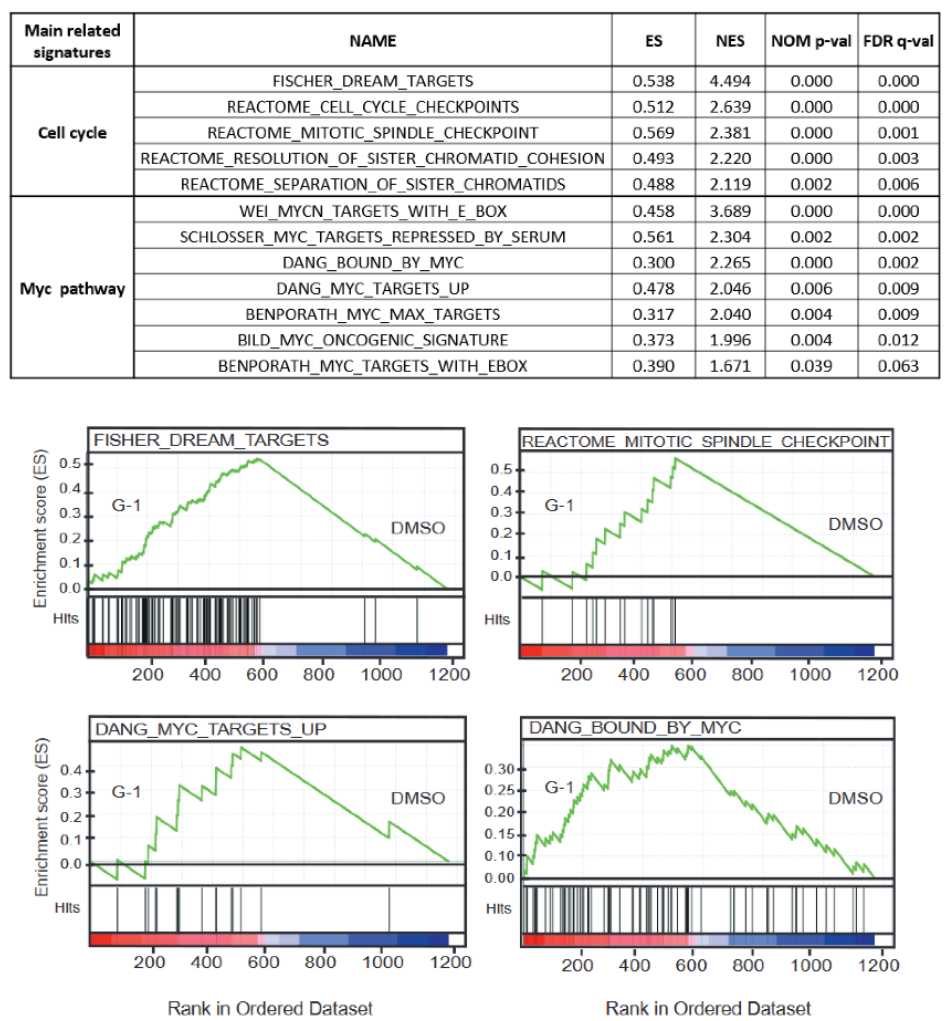
Figure 6. GSEA signature enrichment of G-1 is mainly related to the cell cycle and Myc pathways. GSEA analysis using the gene expression profile of U251 cells exposed to 1 µ M of G-1 for 72 h showed significant positive enrichment for gene sets that are linked to mitotic spindle and chromatid separation and gene sets related to Myc pathway signatures. Table 1. The molecular signature of G-1 resembles to that of microtubule-targeting agents. The Cmap approach was used, allowing identification of the top molecules (tau > 90) whose molecular signatures are close to those of G-1 after 72 h of treatment with 1 µ M of the U251 cell line. Id